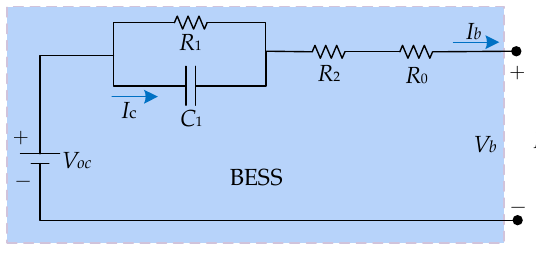
Figure 4. Equivalent circuit model of the BESS.